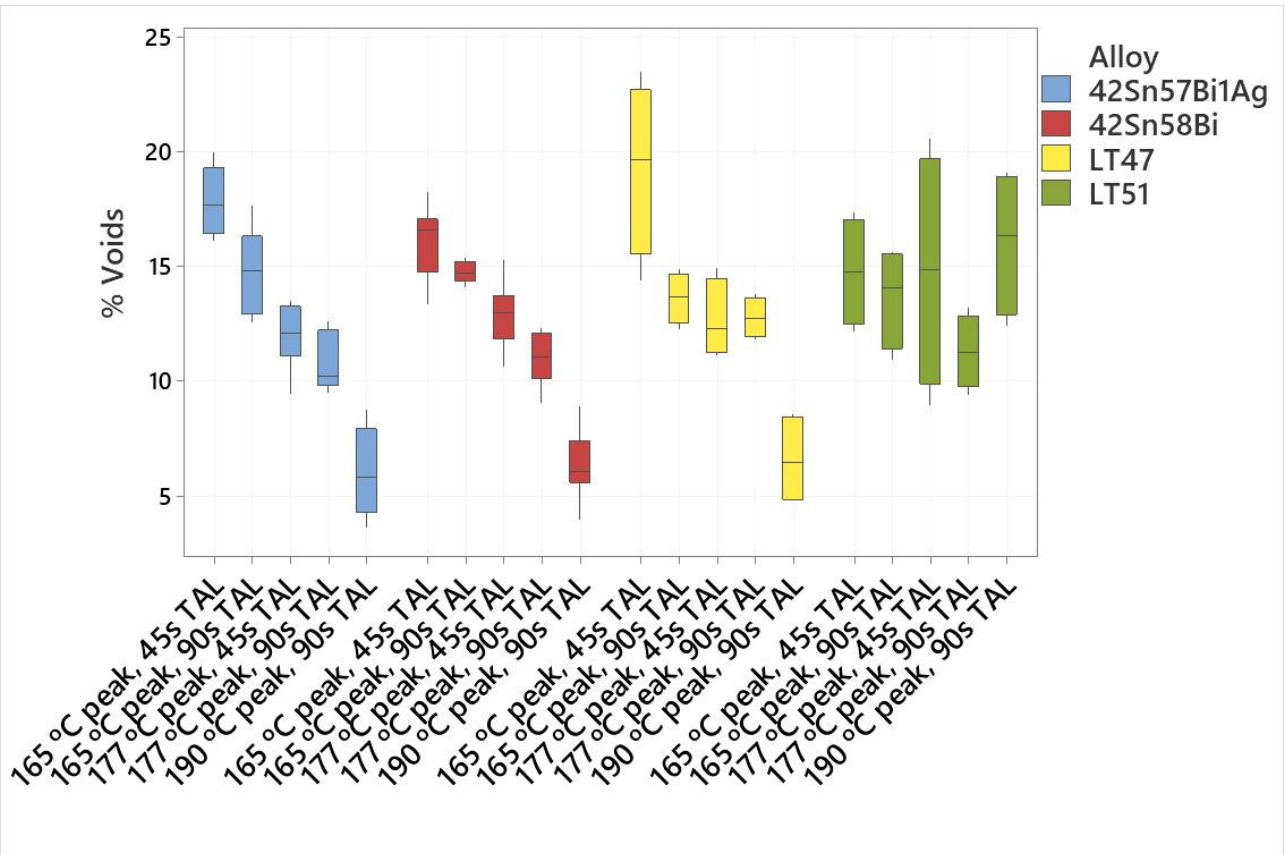
Figure 7. Voiding boxplot demonstrating the average voiding levels measured in quad flat no leads (QFN) components for 42Sn58Bi, 42Sn57Bi1Ag, LT 47 and LT 51.